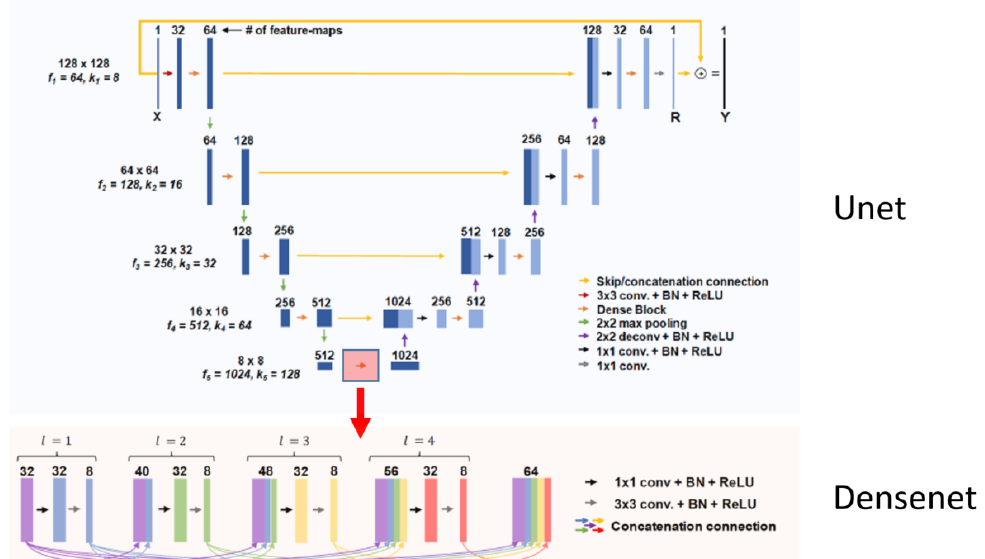
Figure 4. Dense Unet architecture ( top ) used for limited angle tomographic image reconstruction. Example of denseblock structure ( bottom ), with hyperparameters k = 8 and l =